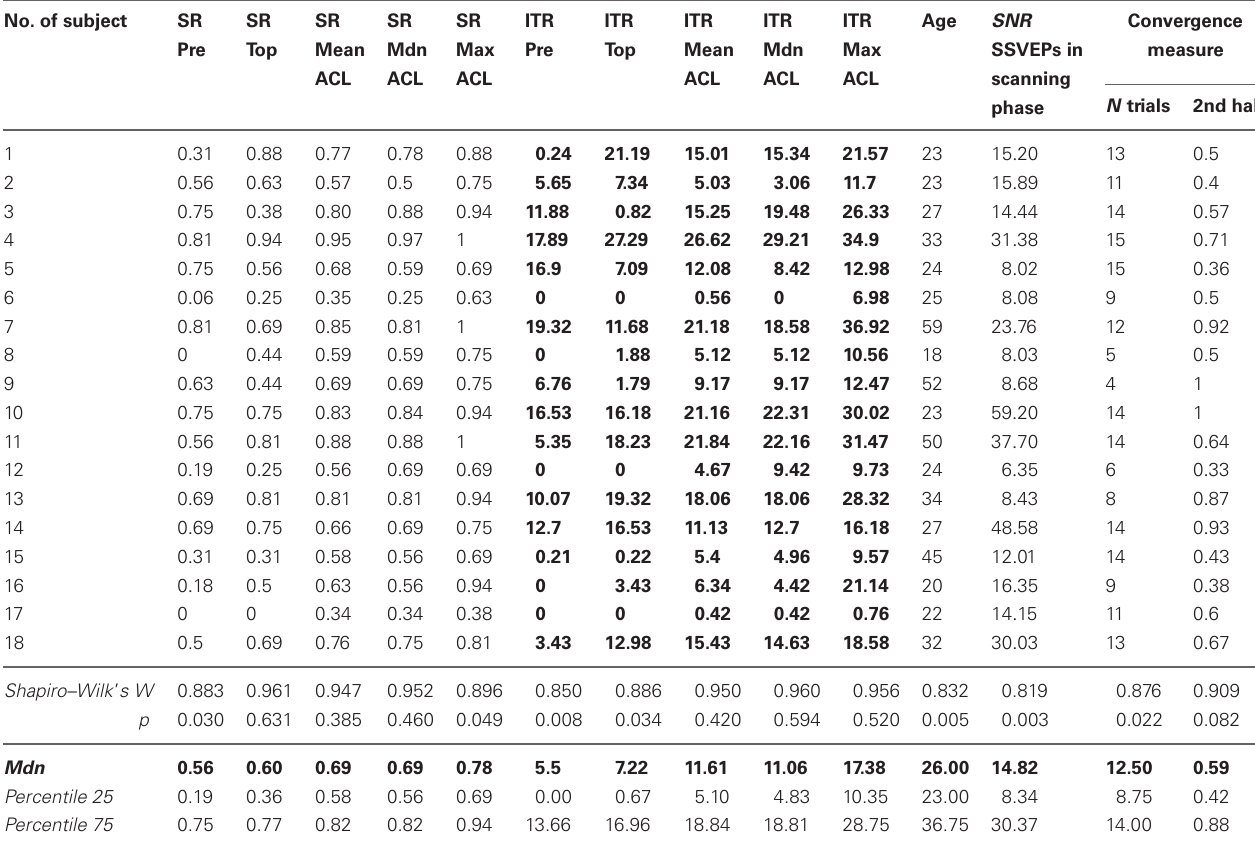
Table 1 | Data of the N = 18 subjects under the three experimental